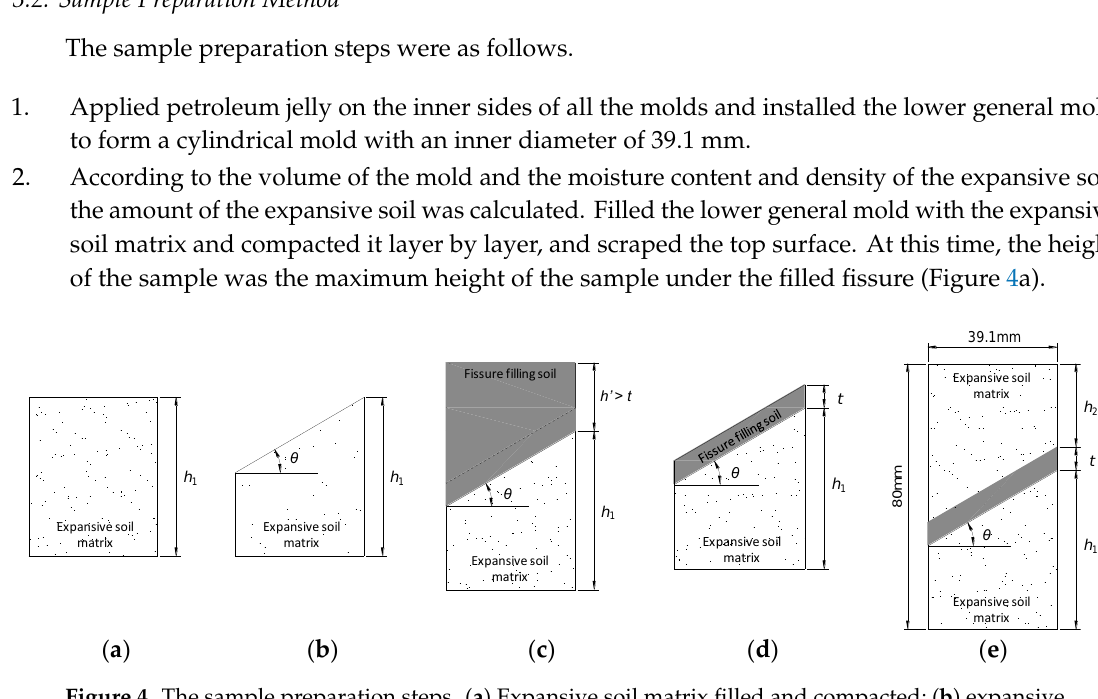
Figure 4. The sample preparation steps. ( a ) Expansive soil matrix filled and compacted; ( b ) expansive soil matrix with a certain inclined top surfaces; ( c ) fissure filling soil filled and compacted until the height exceeded the top of the filled fissure; ( d ) sample cutting to form a filled fissure with a certain inclination; ( e ) expansive soil matrix filled and compacted to complete the sample.